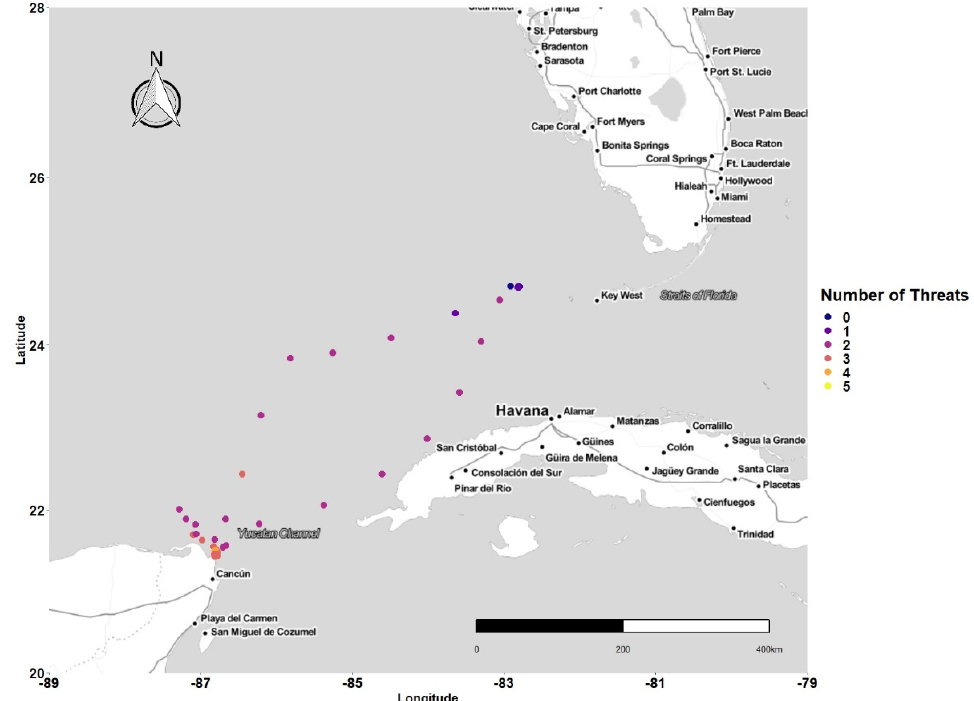
Figure A6. State-space model (SSM) points of Turtle #33, a green turtle ( Chelonia mydas ) that migrated from Dry Tortugas National Park to the Yucatan Peninsula and back between 22 May and 8 August 2015. Each color represents the number of unique high threat categories encountered on that given day within a 2 km buffer of the SSM